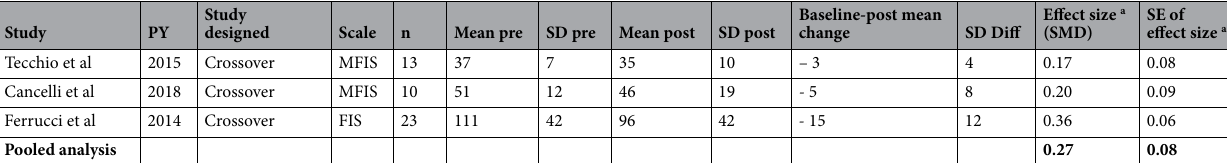
Table 7. Fatigue. Sham. PY = Publication Year. SMD = Standardized Mean Difference. SE = Standard Error. Note: a Correlation pre-post r = 0.96 was assumed to calculate the effect size and the corresponding standard